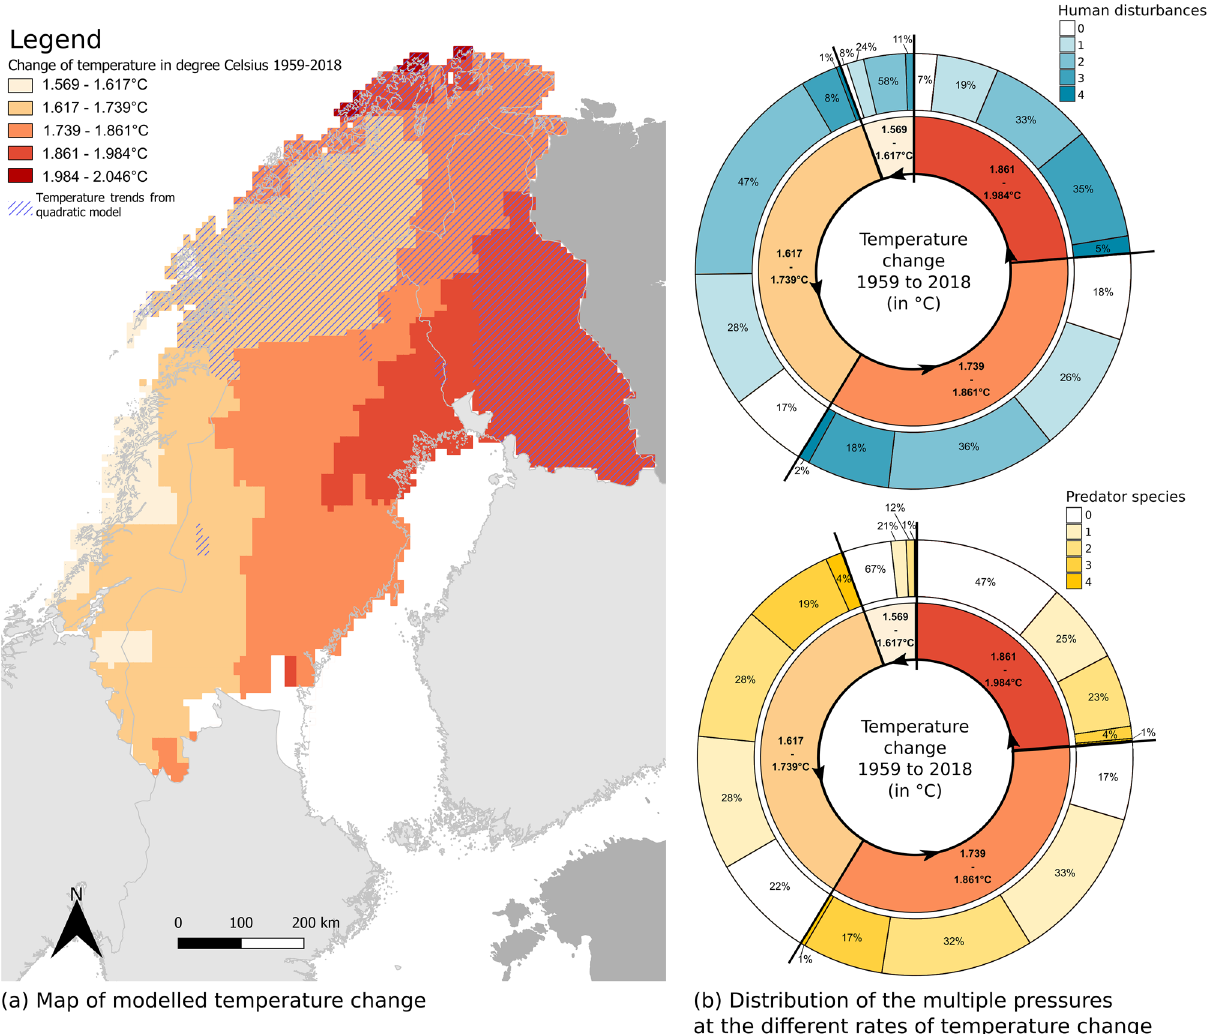
Figure 3. ( a ) Temperature changes over northern Fennoscandia for the last 60 years (1959 to 2018) coloured in shades of red (see legend). The residuals of all the models (linear and quadratic) were normal. The area covered by blue hatched lines are the areas where the quadratic models were a better fit than the linear models, and were therefore used to model temperature change over time. The residuals of these models were normal and not auto- correlated. 4.3% of the linear models were serially auto-correlated, therefore excluded and shown in white. This map was created with QGIS version 3.4.7, accessed on www. qgis. org. The country borders were from Eurostat ©EuroGeographics. ( b ) Distribution of the multiple pressures (co-occurring land-uses in shades of blue and co-occurring predator species in shades of yellow) at the different rates of temperature change up to 1.984 °C. For each specific rate of temperature change, the percentages show the extent (in number of grid cells) under cumulative pressures. Note that six grid cells contained five land-uses but were not included in this graph for visual